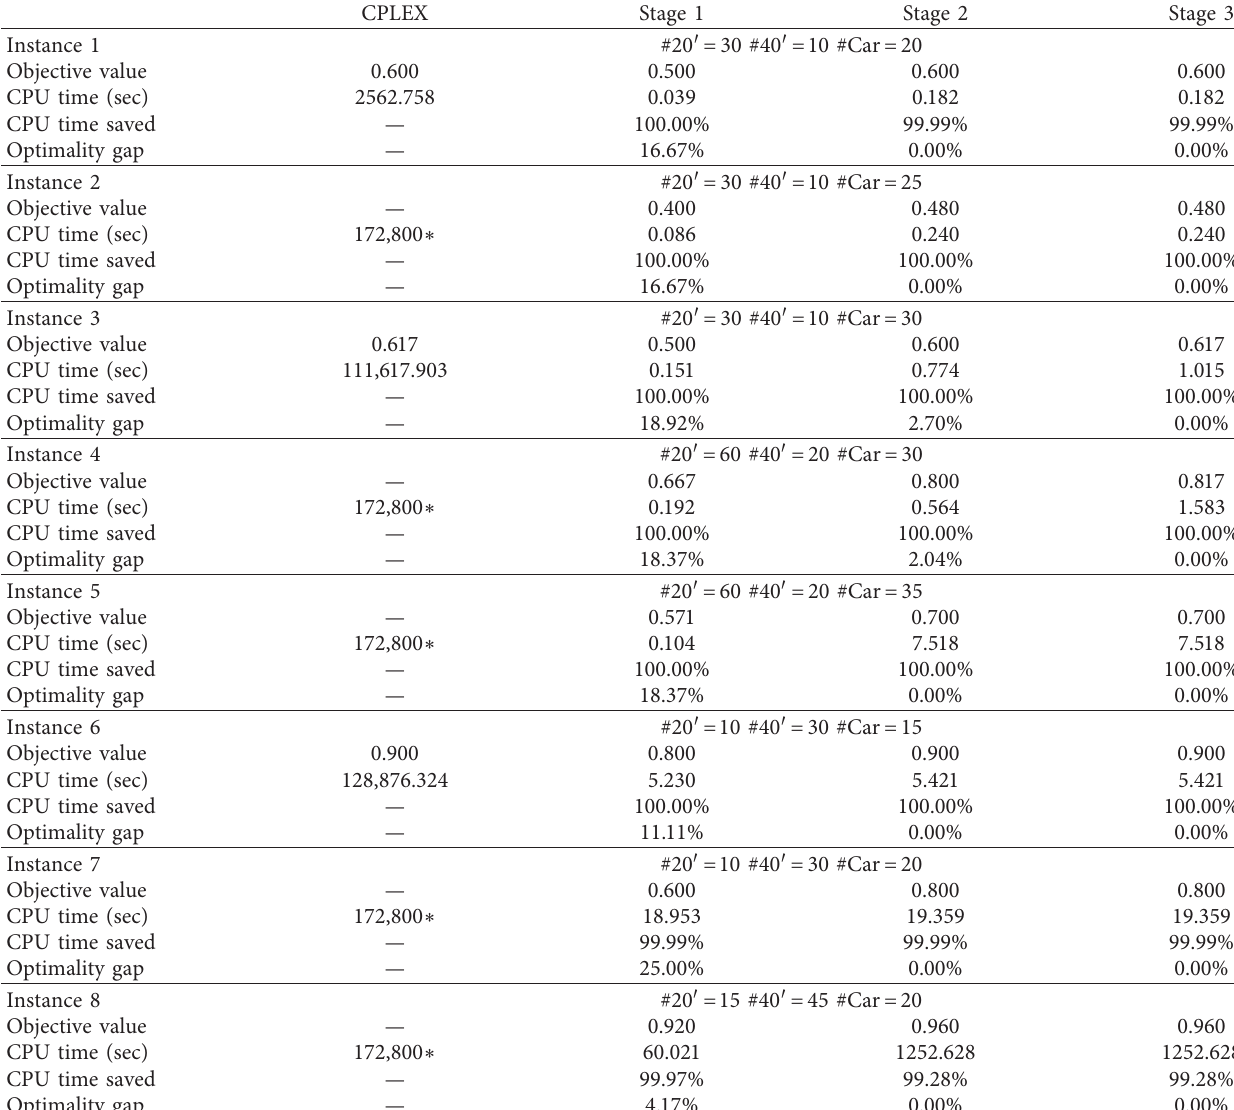
Table 2: Empirical